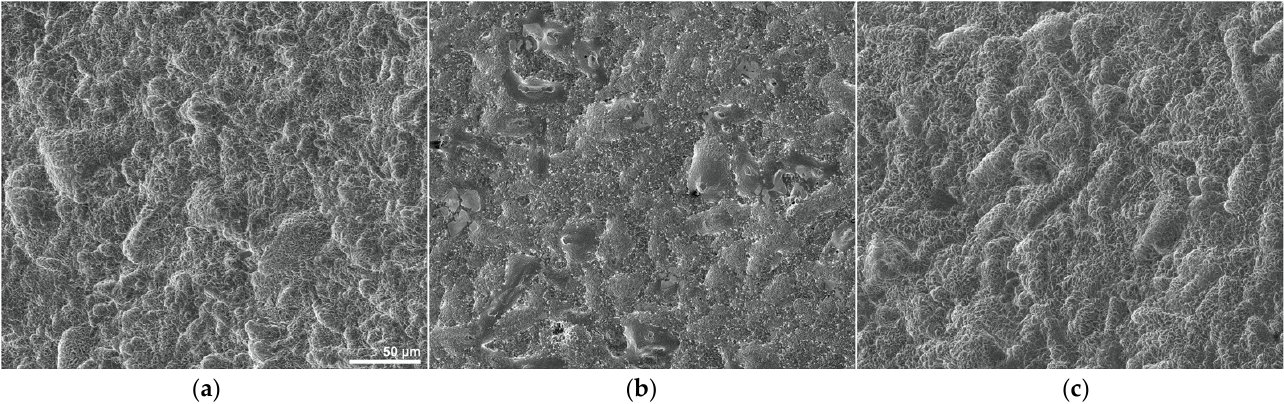
Figure 1. SEM micrographs (1000×) providing an overview of ( a ) ABT, ( b ) Nano and ( c ) Nano H 2 O titanium discs at low magnification (horizontal field width of 298 µm).